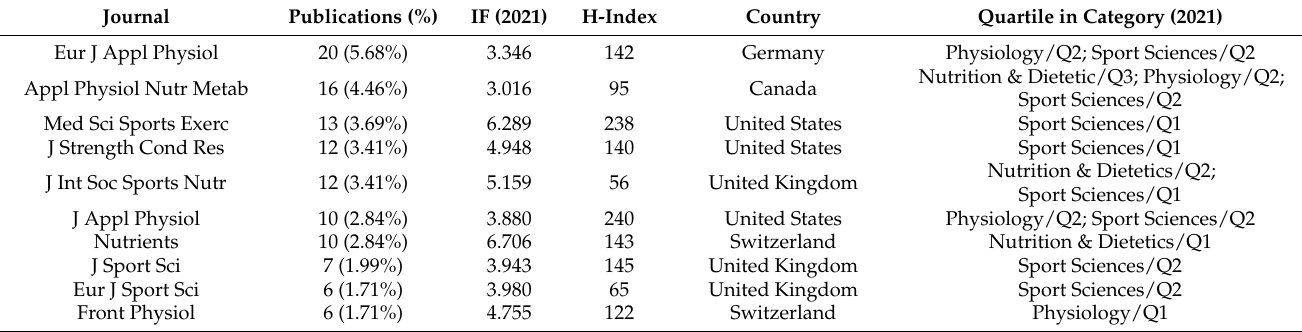
Table 1. The top ten journals of EIMD and protein intake studies ranked by number of